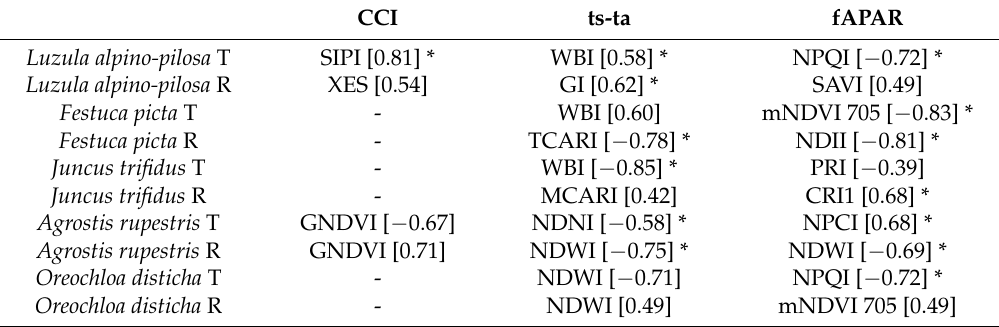
Table 4. The Spearman correlation remote sensing vegetation indices and bio-radiometric indices (CCI, ts-ta, fAPAR) for all investigated species marked. T, trampled; and R, reference; “-”, no correlate; *, statistical significance at the 0.05